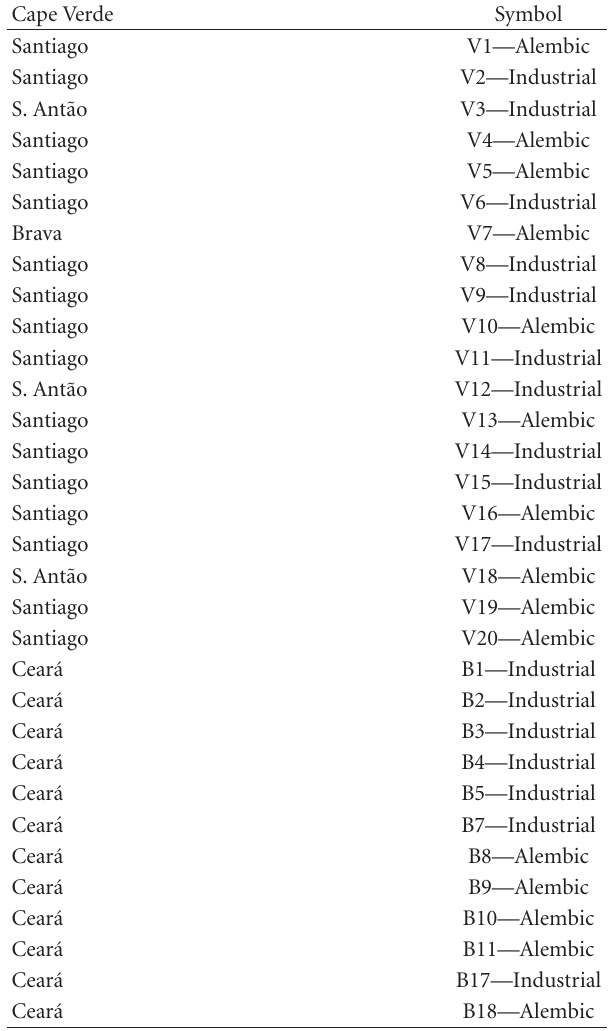
Table 1: Identification of the spirits of Cape Verde and